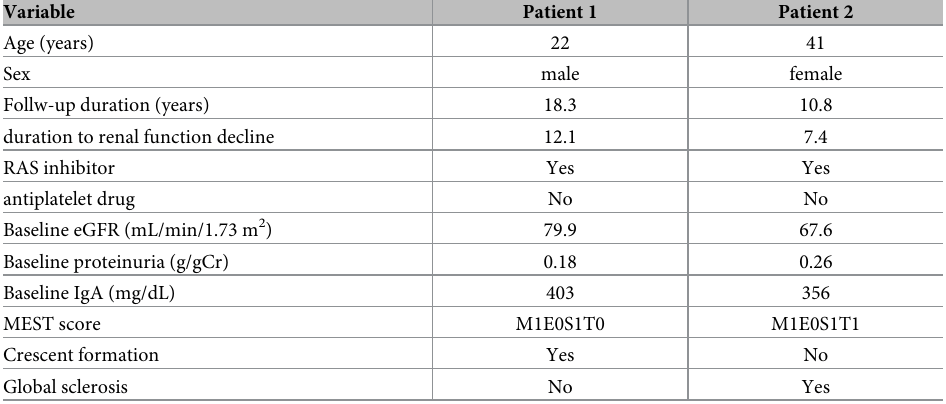
Table 5. Clinical characteristics of two patients with benign presentation at diagnosis who showed renal function